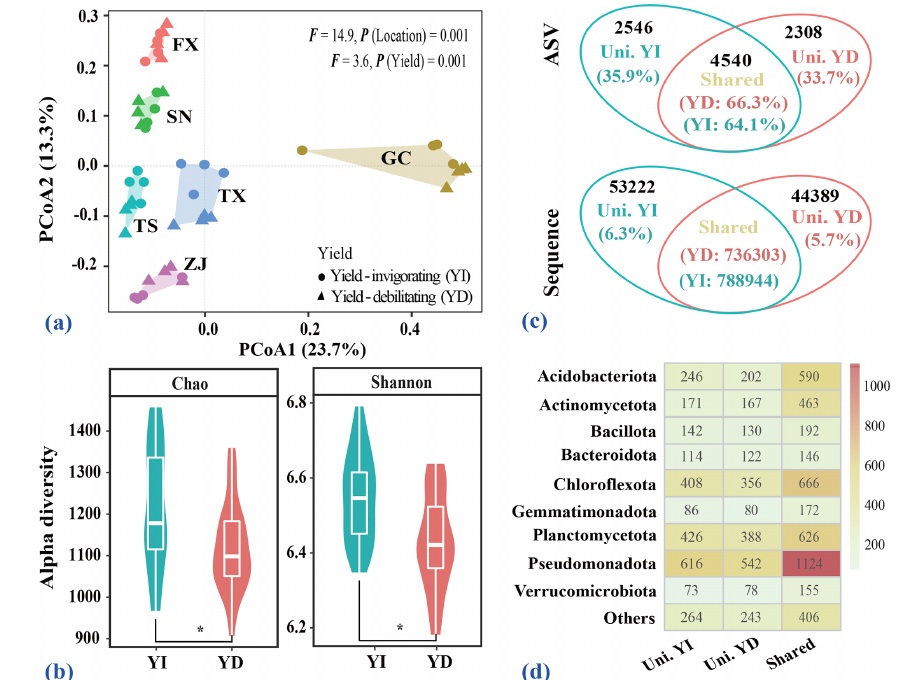
Figure 3. Overview of bacterial composition and alpha diversity. (a) Principal Coordinates Analysis (PCoA) plot displaying the bacterial community composition calculated based on Bray–Curtis distances. (b) Violin plot showing the alpha diversity indices (Chao and Shannon) for all selected orchards. Asterisk indicates a significant difference between yield-invigorating (YI) and yield-debilitating (YD) orchards based on Wilcoxon tests ( p < 0 . 05). (c) Venn plot depicting the unique and shared bacterial ASVs between yield-invigorating (YI) and yield-debilitating (YD) orchards at ASV and sequence insights. Uni. YI and Uni. YD represent unique ASVs or sequences in the YI or YD soils while Shared represent shared ASVs or sequences between the YI and YD soils. (d) Heatmap displaying the composition of unique and shared ASVs at phylum level in YI and YD soils. Numbers in the cell represent the number of ASVs affiliated to that phylum.